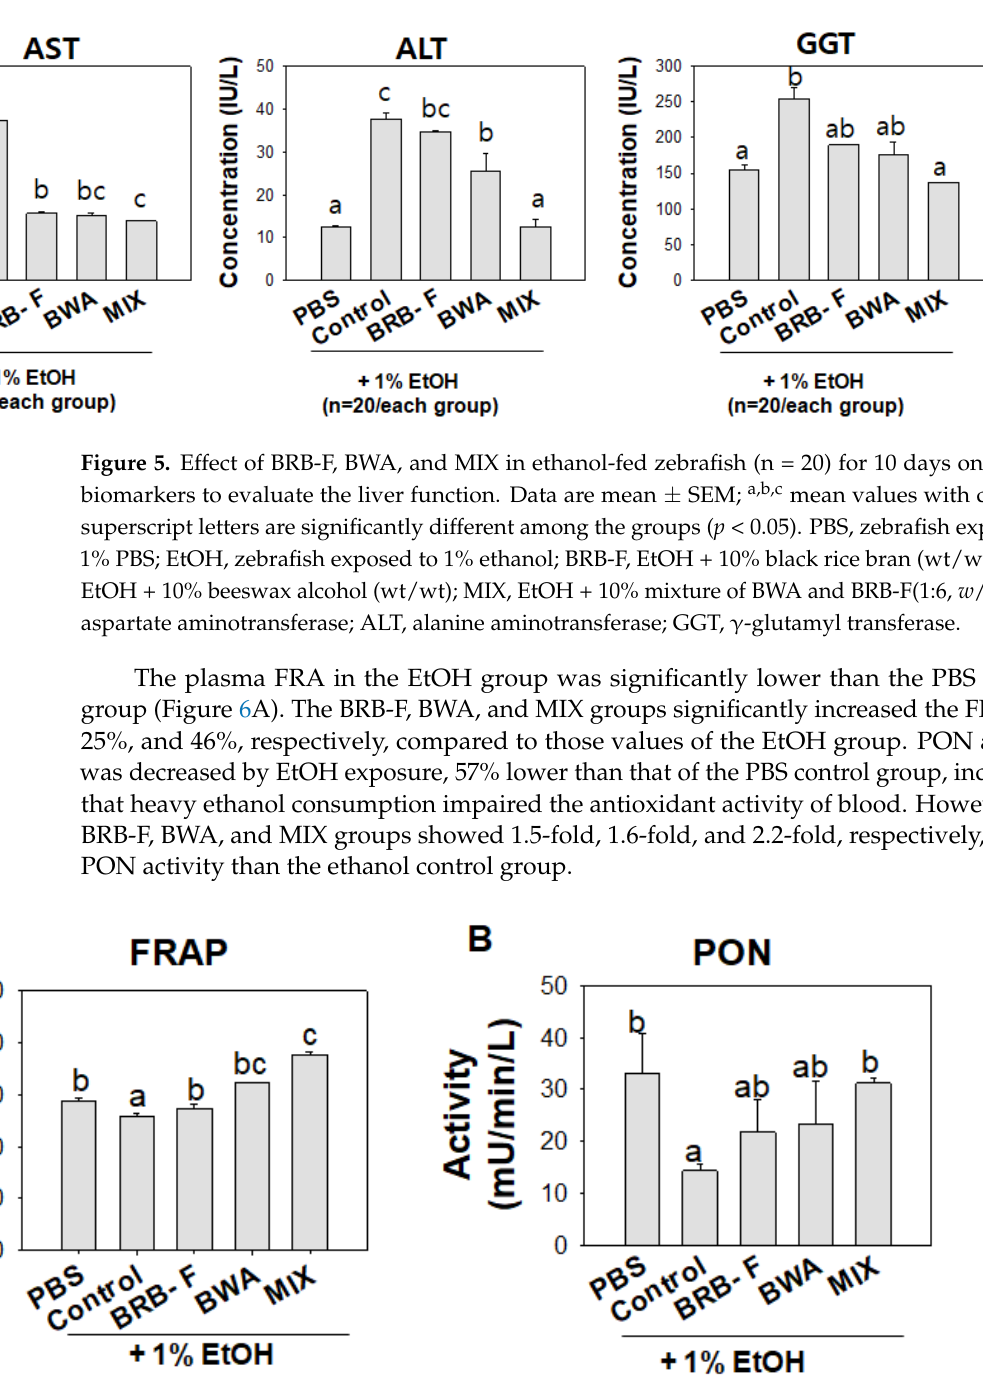
Figure 6. Effect of BRB-F, BWA, and MIX in alcohol liver injury zebrafish for 10 days on the ferric- reducing ability of plasma ( A ) FRAP values and ( B ) paraoxonase activity. The data are mean ± SEM; a,b,c mean values with different superscript letters are significantly different among all groups ( p < 0.05). PBS, zebrafish exposed to 1% PBS, n = 20; EtOH, zebrafish exposed to 1% ethanol, n = 20; BRB-F, EtOH fed 10% black rice bran, n = 20; BWA, EtOH fed 10% beeswax alcohol, n = 20; MIX, EtOH fed a mixture of BWA and BRB-F (1:6, w / w ), n = 20; FRAP, ferric-reducing ability of plasma; PON,